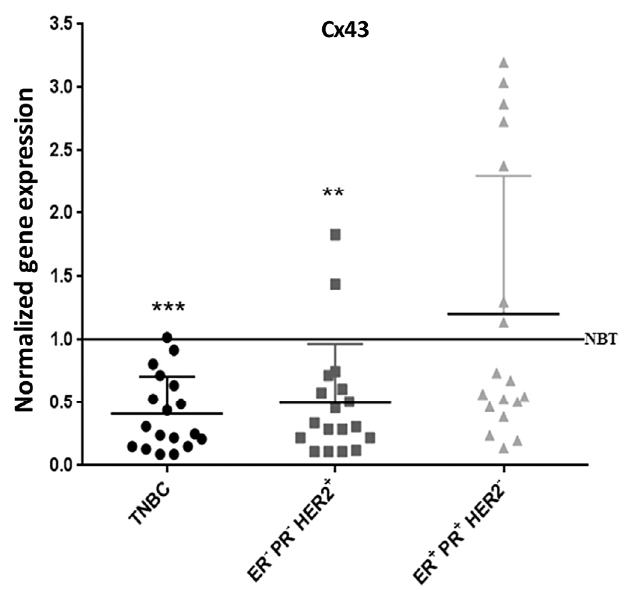
Figure 8. Cx43 expression is down-regulated in TNBC patients. qPCR analysis of Cx43 in TNBC, ER − PR − HER2 + and ER + PR + HER2 − subtypes of human breast cancer, after normalization to GAPDH. Results are plotted as fold change normalized to the expression level of Cx43 mRNA in normal breast tissues (NBT). ** p < 0.01; *** p < 0.001.